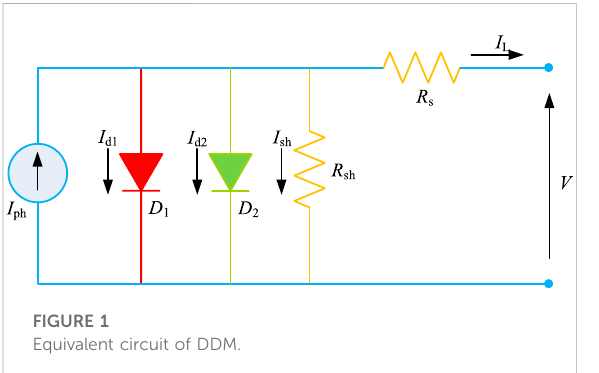
FIGURE 2 Equivalent circuit of